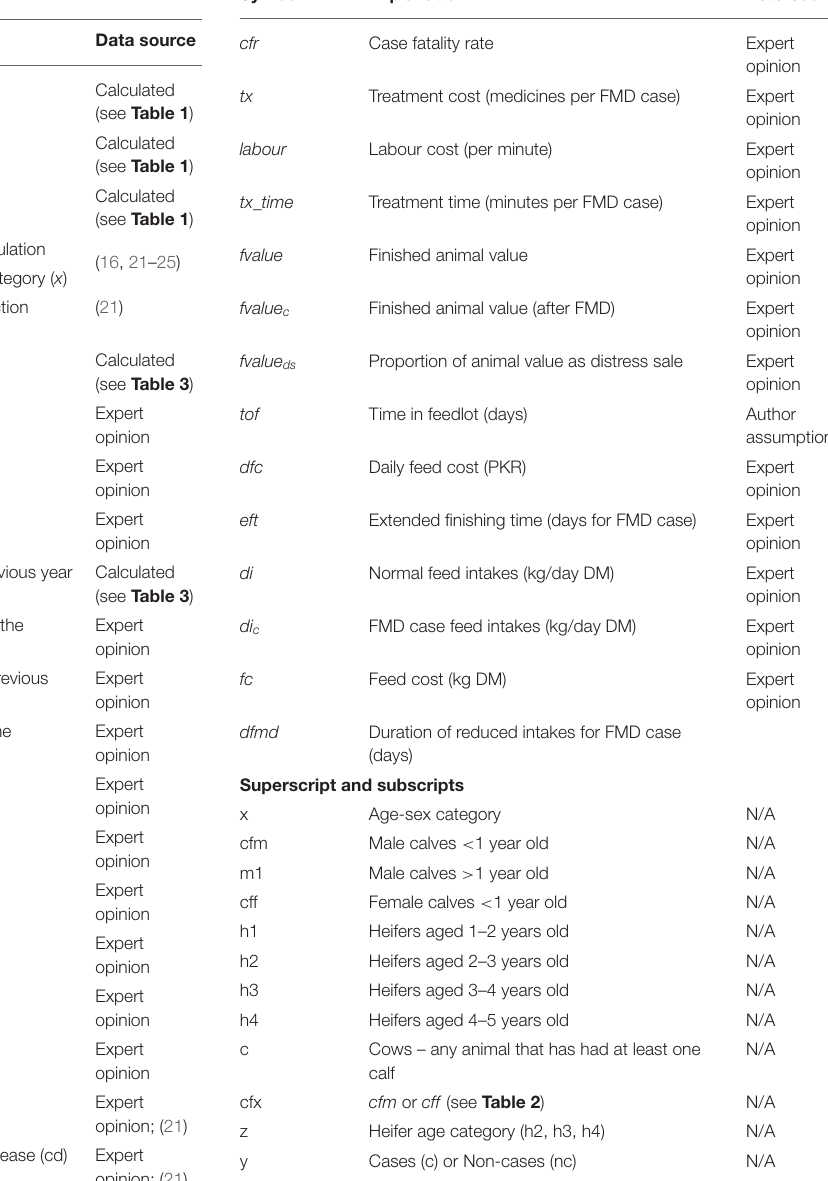
TABLE 2 | Explanation of model symbols for estimating the impact of foot-and-mouth disease (FMD) on a farm in terms of fertility, herd structure, and milk